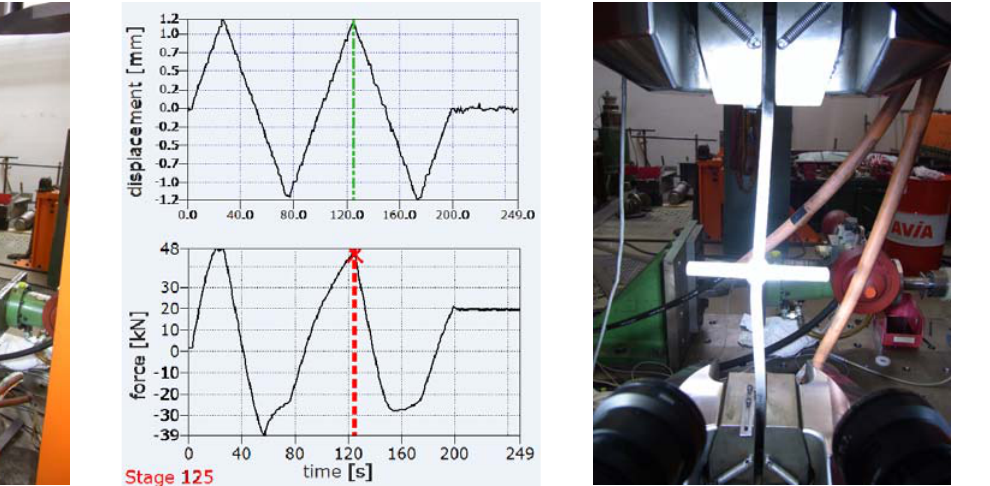
Figure 9: Deformed specimen at F min .